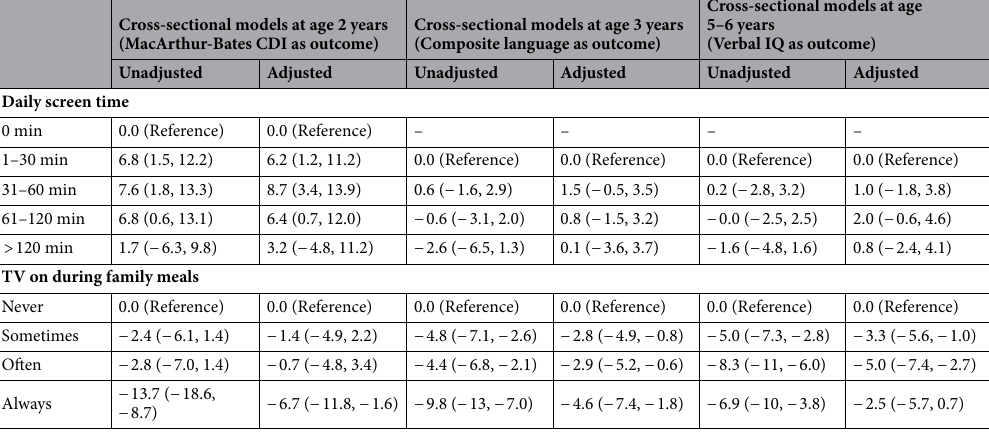
Table 3. Unadjusted and adjusted cross-sectional associations between exposure to screens and child language development at each time point in the EDEN cohort (N = 1,562). a CDI Communicative Development Inventory, IQ intelligence quotient, HOME Home Observation Measurement of the Environment. a Values are adjusted mean differences (vs the reference group) from linear regression models conducted on multiply imputed datasets (n = 1,562). Models are of cross-sectional design, i.e., outcomes are being predicted by exposure to screens as measured at concomitant age. Exposure to screens variables (Daily screen time and TV on during family meals) were mutually adjusted for each other. Adjusted models were further adjusted for the following covariates: study center, maternal age at delivery, pre-pregnancy body mass index, tobacco and alcohol consumption during pregnancy, symptoms of postpartum depression, child sex, gestational age at birth, birthweight, breastfeeding duration, number of older siblings, parental education level, bilingual household, maternal and paternal language difficulties during childhood, household income, main caretaker, cognitive stimulating activities, HOME score. Models at ages 2 and 3 years were further adjusted for the child’s exact age at language assessment (verbal IQ scoring accounts for age). Models at age 3 years were further adjusted for schooling duration.